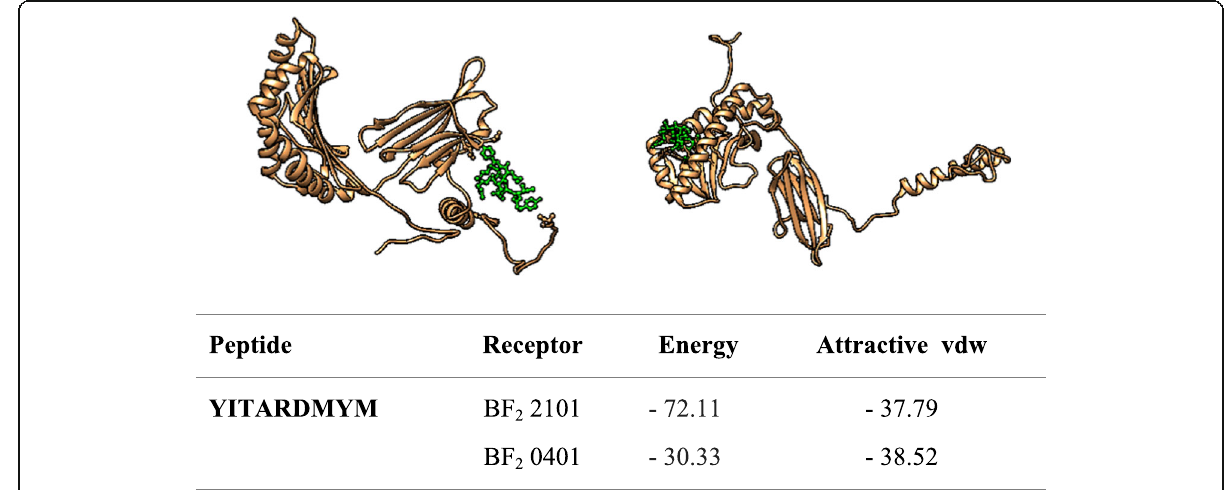
Fig. 7 Docking of YITARDMYM with BF 2 alleles